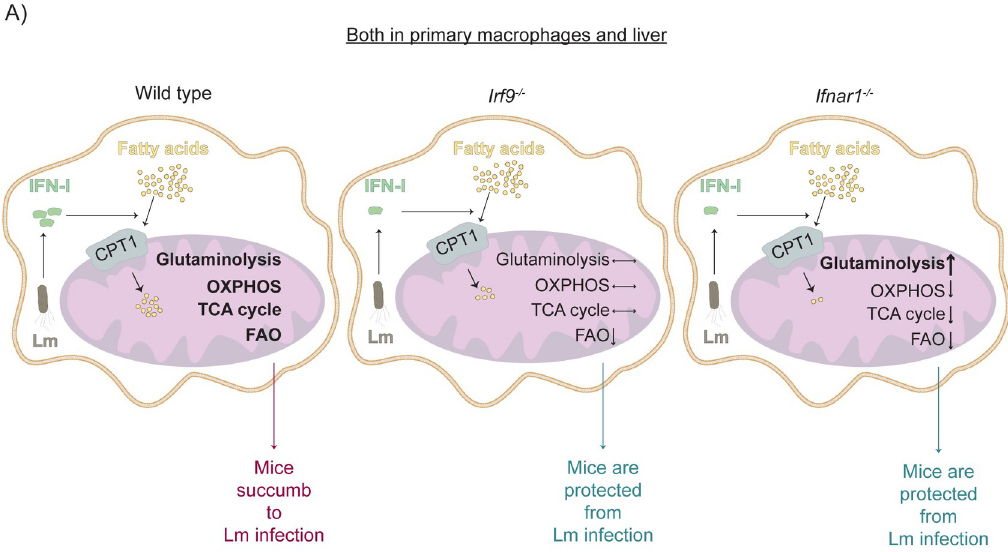
Fig 6. Model of Listeria monocytogenes -induced metabolic rewiring. (A) Listeria monocytogenes (Lm) induced-IFN-I regulate FA import into the mitochondria. Absence of autocrine IFNAR1 signalling leads to decreased fatty acid oxidation (FAO) in Irf9 -/- and Ifnar1 -/- BMDMs and livers, and also reduced TCA cycle intermediate levels and oxidative phosphorylation (OXPHOS) as well as increased glutaminolysis exclusively in Ifnar1 -/- BMDMs and livers.